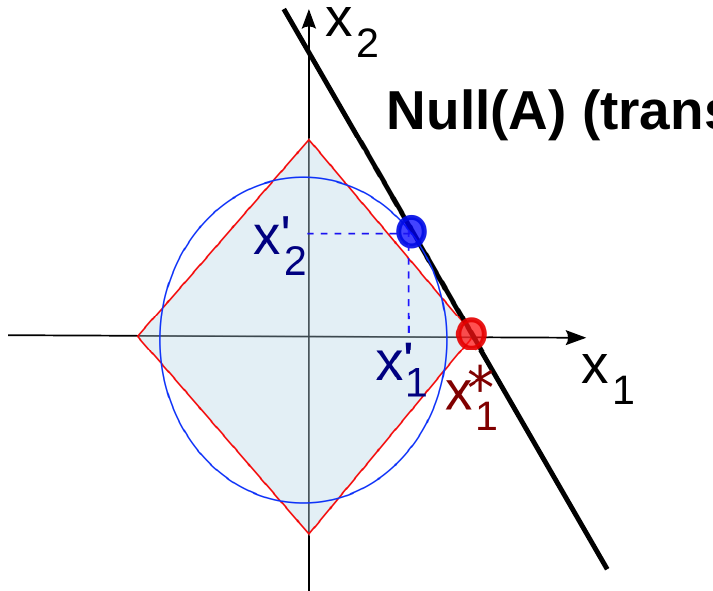
Figure 13. The solution of the (cid:96) 1 minimization problem is the intersection point ( x ∗ convex sets, the (cid:96) 1 ball drawn as a red curve and the set of the points x solution of the equations Ax = y ; in the figure, the solution of the (cid:96) 2 minimization problem is also plotted, which is the intersection point ( x (cid:48)(cid:48) ) between the (cid:96) , x (cid:48) 2 ball drawn as a blue curve and the set of the points x solution of the 2 1